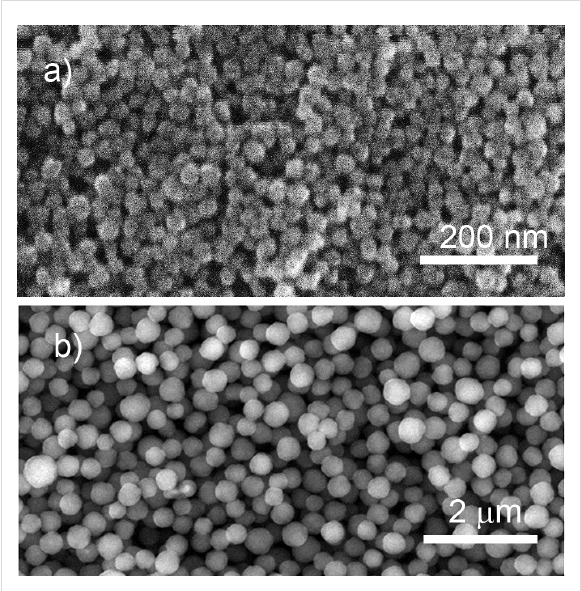
Figure 10: SEM images of the PTFE-sputtered NPs deposited with dif- ferent intensity of the magnetic field: a) 100 G, b) 250 G; Ar pressure is 100 Pa, flow rate is 9.2 sccm, residence time is 9 s, discharge power is 140 W, deposition time is 20 min; obtained in a similar manner as in